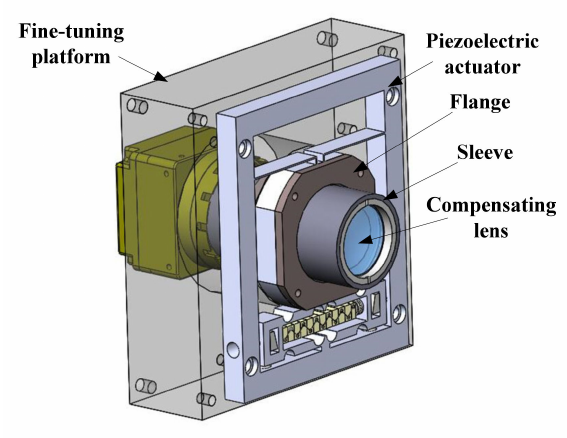
Figure 13. The connection mechanism of the compensating